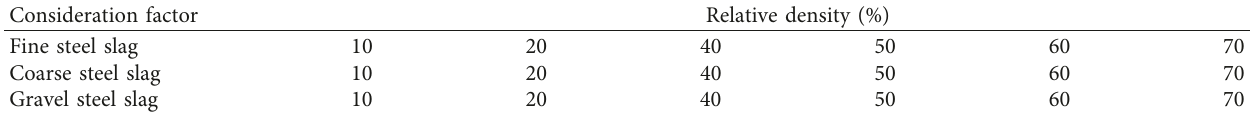
Table 5: Setting levels of relative density considered in permeability tests.